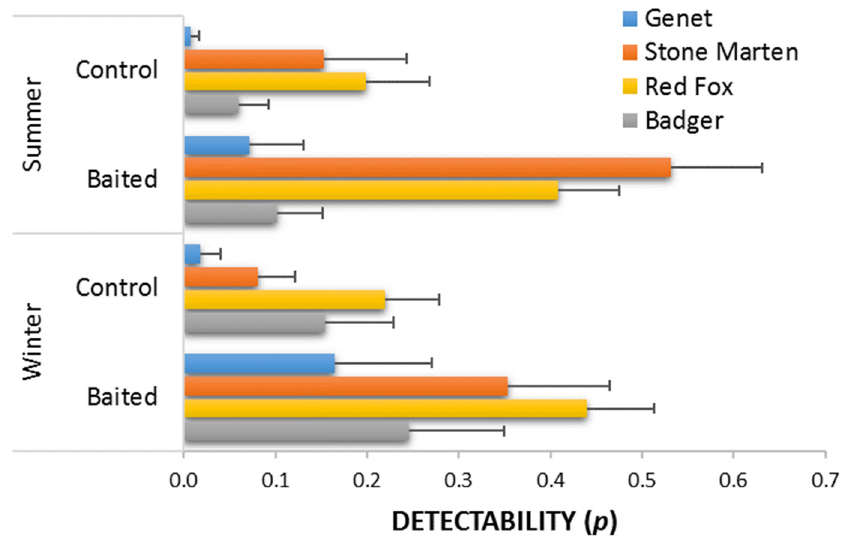
Figure 3. Seasonal modelled probability of detection (detectability, p ± SE) of the four wild meso- carnivore species according to the use of bait in alternate positions in camera stations within the 16 line-transects of four cameras each.